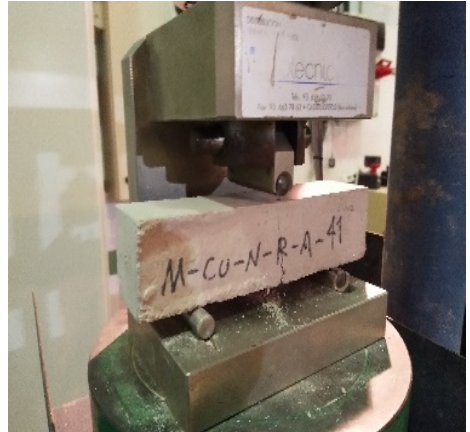
Figure 6. Flexural test.